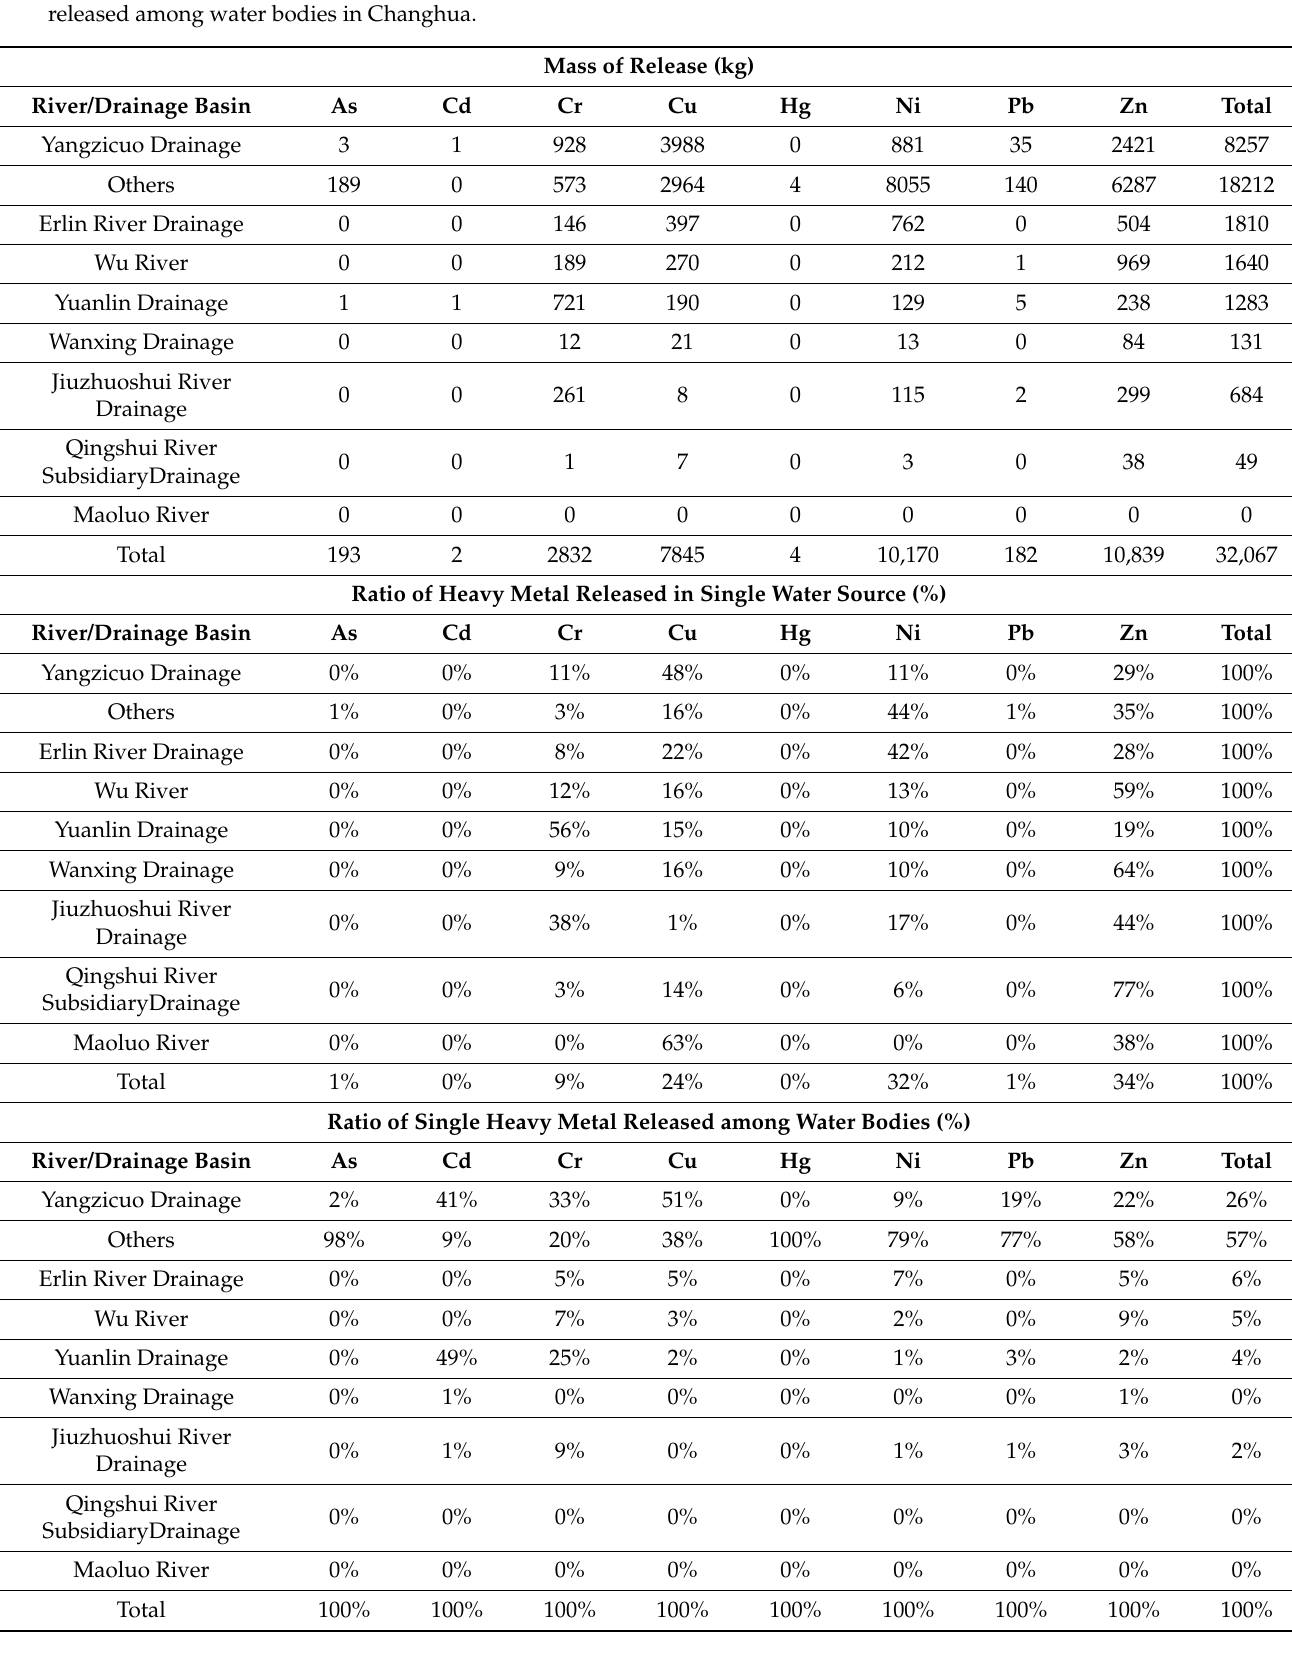
Table 4. The mass of release, the ratio of heavy metal released in single water source, and the ratio of single heavy metal released among water bodies in